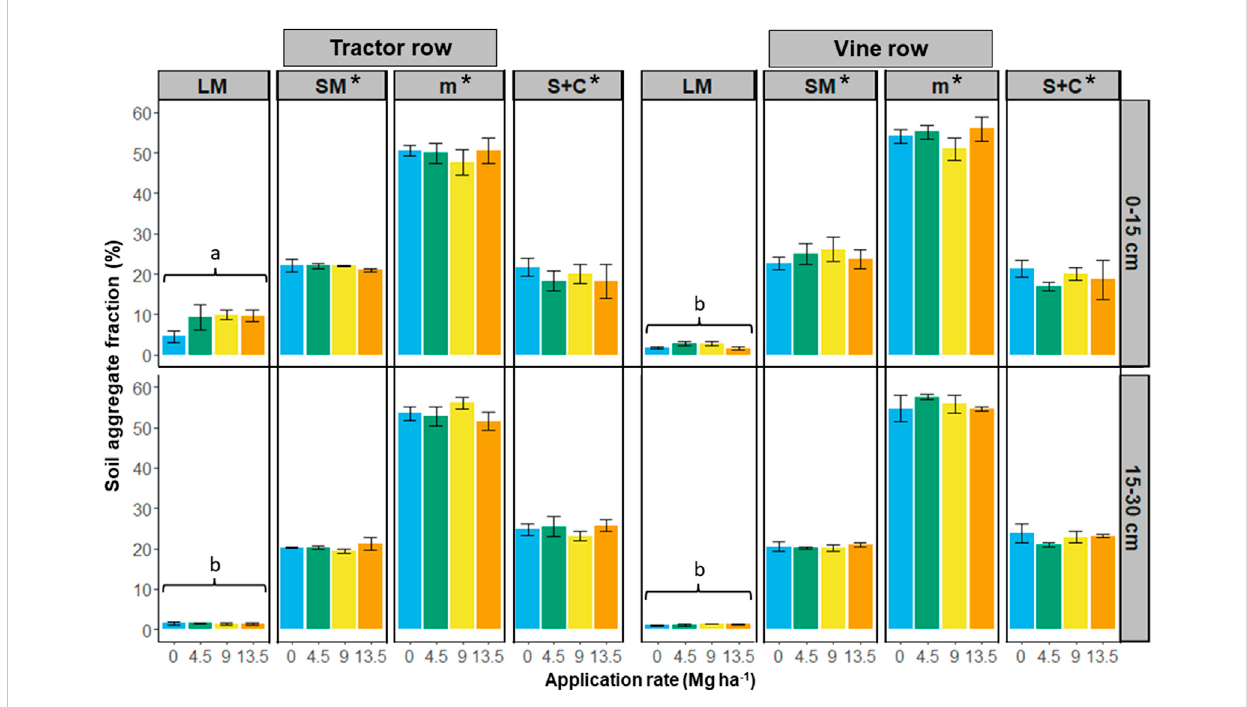
FIGURE 3 Fractions (%) of soil aggregates by size and functional location at the depths of 0 – 15 and 15 – 30 cm after two years of compost application. LM, SM, m,andS+Crepresent:largemacroaggregate,smallmacroaggregate,microaggregate,andsiltandclay,respectively.Errorbarsarestandarderrorsofthe means(n=4).Lowercaselettersindicatesigni fi cantdifferencesbetweenlocationsanddepths,whileasterisks(*)indicatesigni fi cantdifferencesbetween depths at p < 0.05 within each aggregate size category.